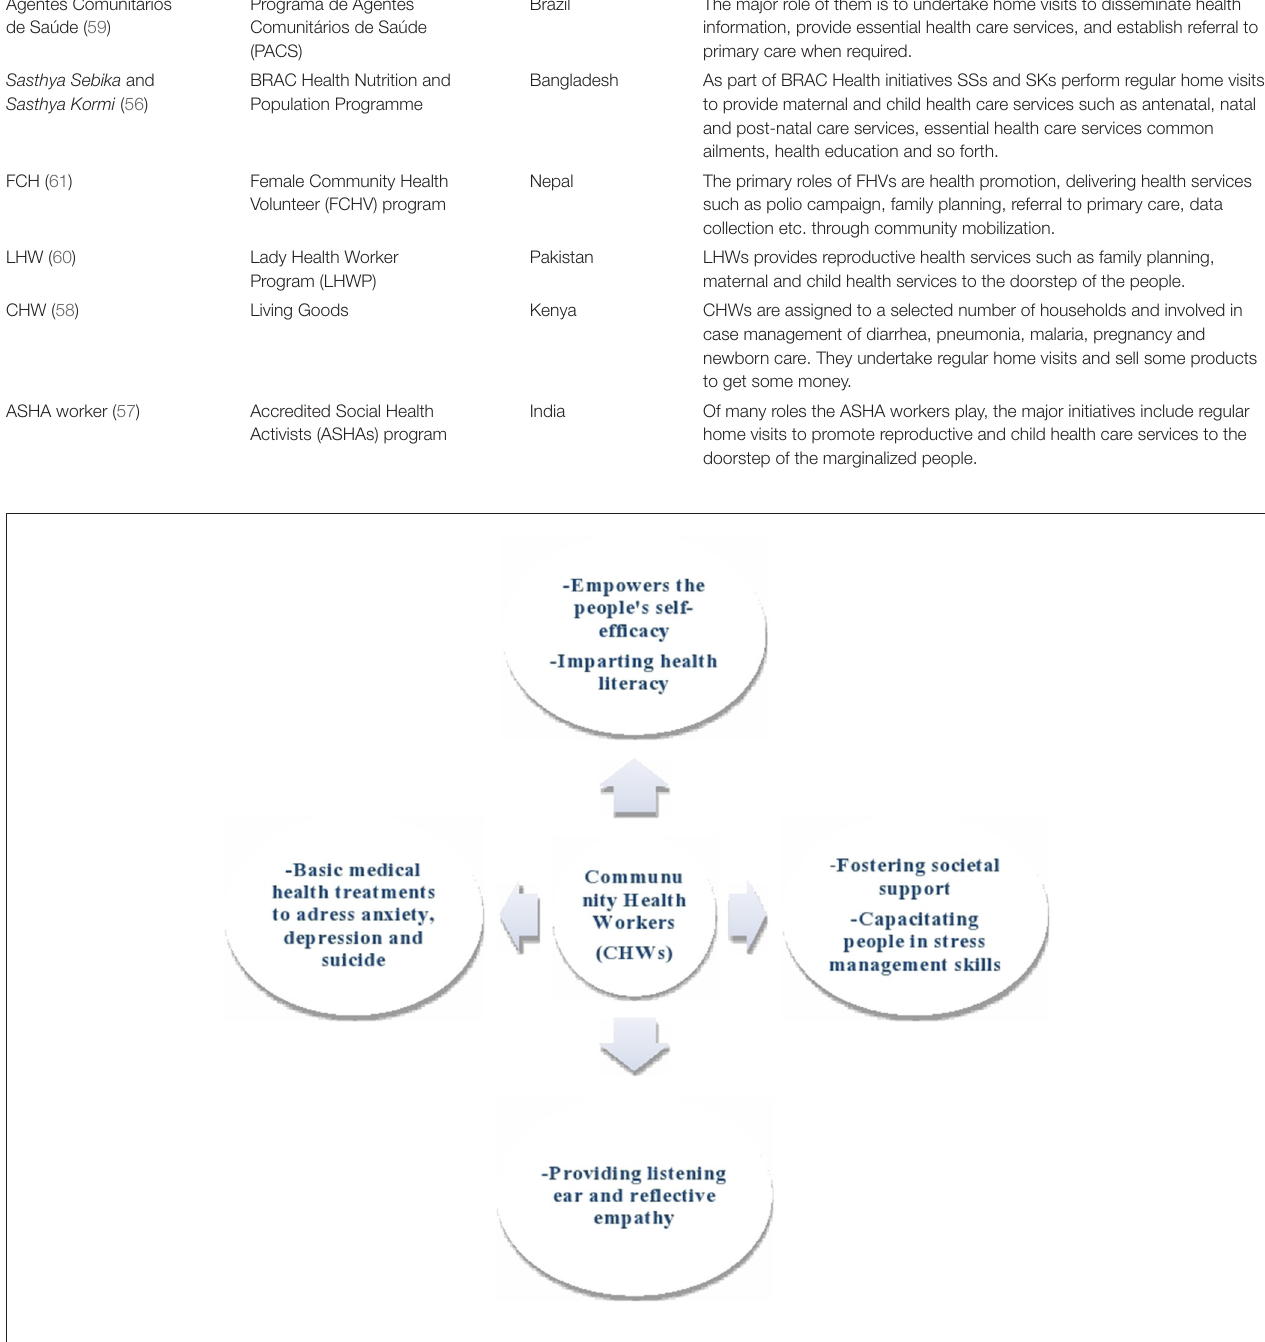
FIGURE 1 | Potential roles of CHWs in providing psychosocial